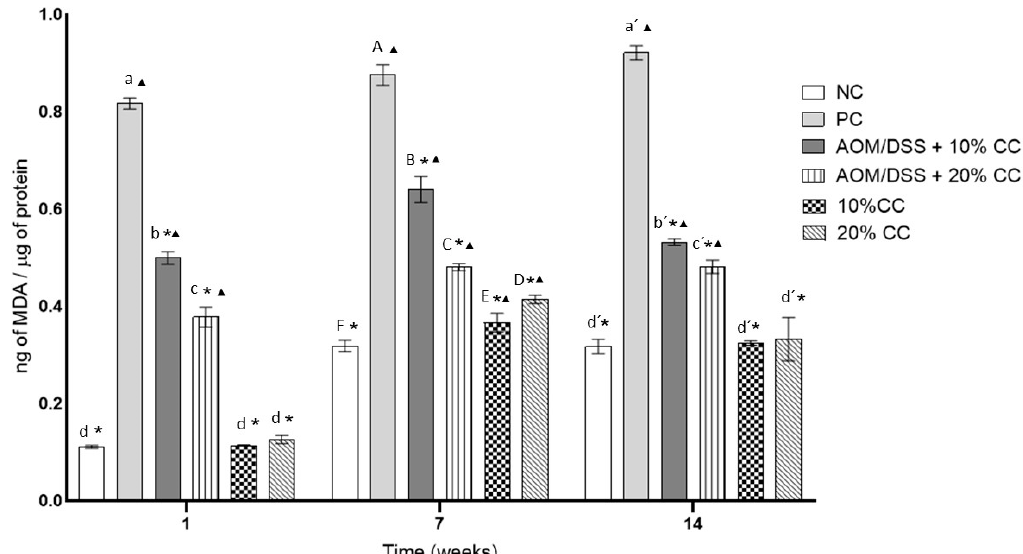
Figure 4. Malondialdehyde (MDA) content in the colon due to the effect of oxidation caused by AOM/DSS in BALB/c mice studied in three periods. Lowercase letters correspond to Week 1, uppercase letters correspond to Week 7, and raw letters correspond to Week 14. * means significant difference from the PC in the same evaluation week and ▲ significant difference with respect to the NC in the same evaluation week. One-factor ANOVA ( p ≤ 0.05), Dunnett’s test. Different letters indicate significant difference ( p < 0.05) in the same evaluation week by Tukey’s test. Values are presented as the mean ± S.D. from four experimental replicas.